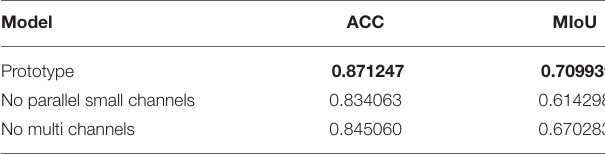
TABLE 4 | Model performance with different